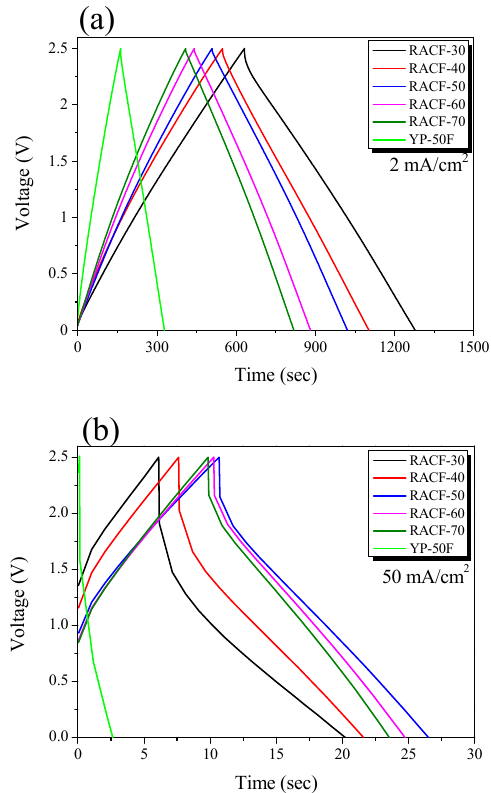
Figure 6. GCD curves of RACF as a function of various steam activation conditions with current densities of: ( a ) 2 mA/cm 2 , ( b ) 50 mA/cm 2 .